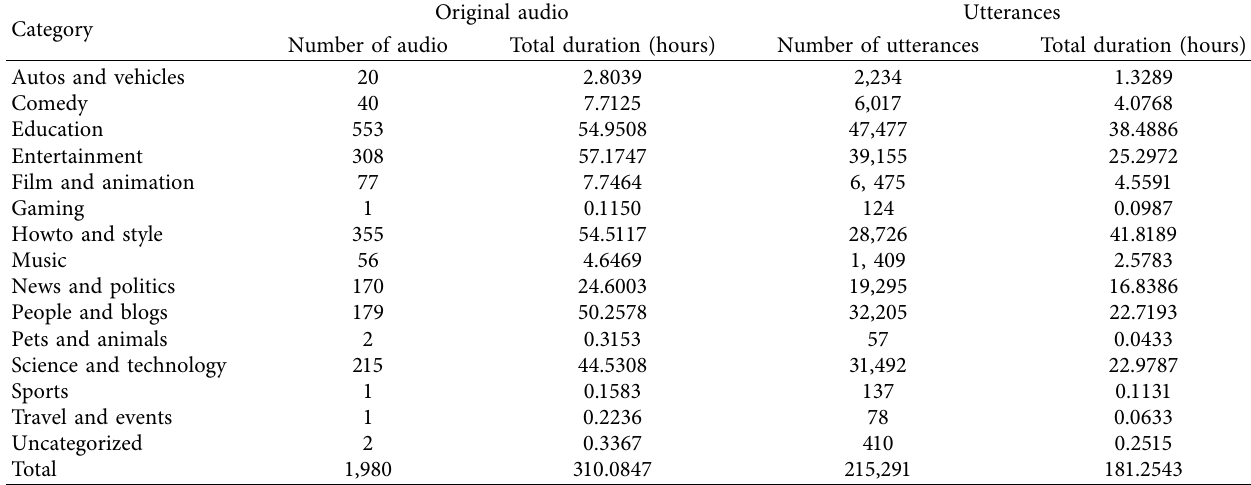
Table 3: The Indonesian audio dataset before validation.